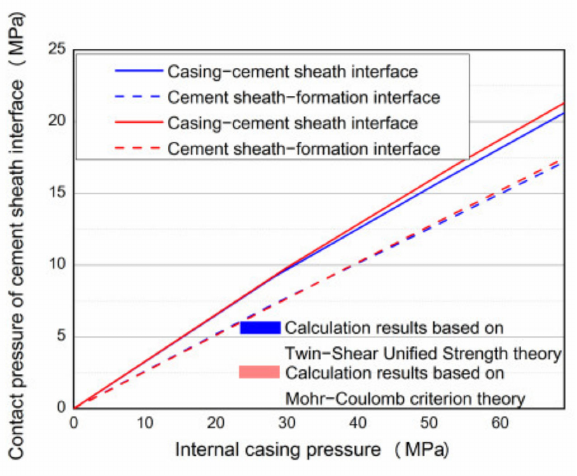
Figure 5. Change in the contact pressure at the cement sheath interface during